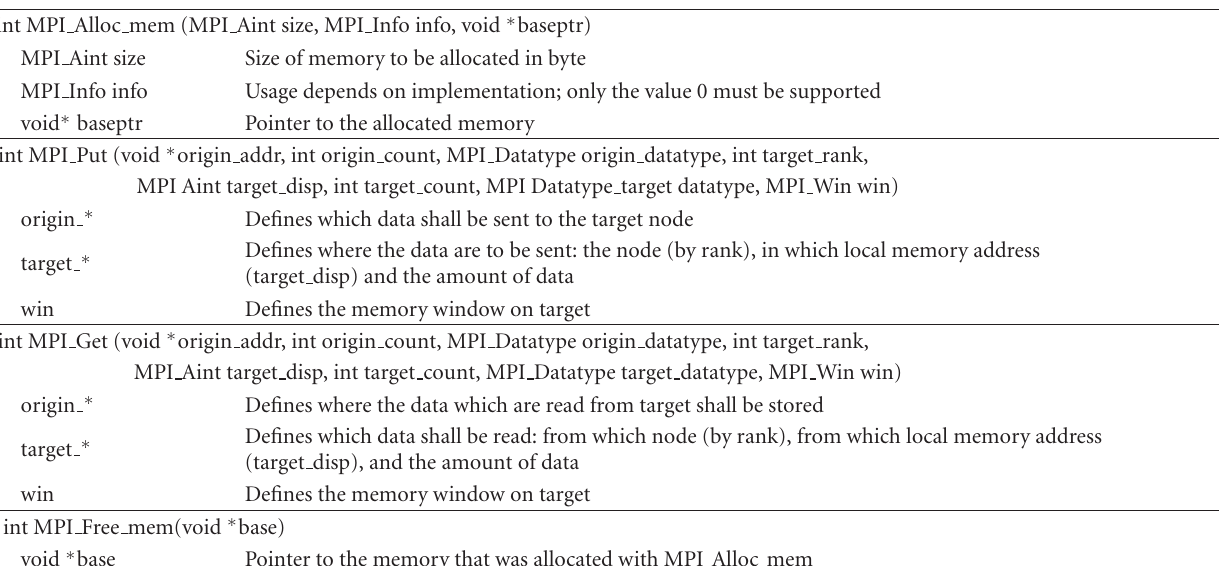
Table 1: MPI functitons used for accessing the adaptive memory